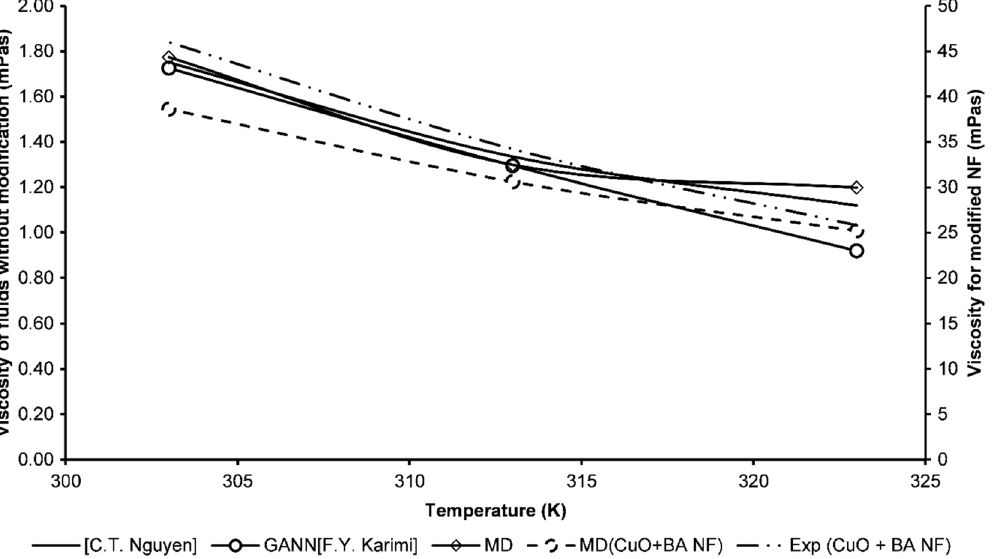
Figure 13. Viscosity of surfactant modified CuO nanofluid and CuO nanofluids.